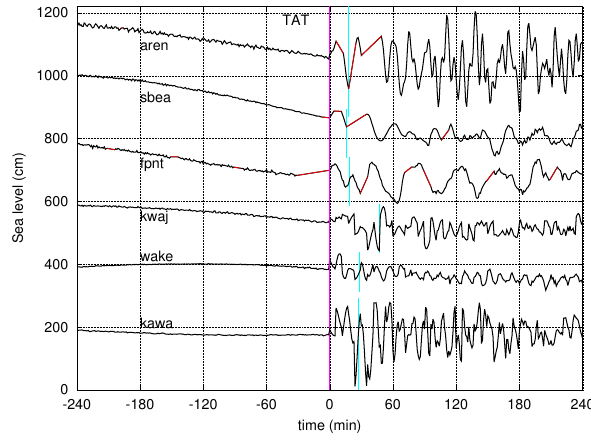
Fig. 3c. Examples of analyzed records given to show how the first tsunami wave has been characterized in case of missing data and in case of complex signals. Records are not detided and are aligned starting from TAT. The end of the first wave is indicated with a light blue line. The records of Arena Cove, California (aren), of South Beach (sbea) and Fort Point (fpnt) both in San Francisco, California, have substantial data gaps making it hard to identify TAT as well as duration and magnitude of the first wave. The records of the Kwajalein atoll, Marshall islands (kwaj), of the Wake island, USA (wake) and of Kawaihae, Hawaii (kawa) are quite complex and the first tsunami wave is modified by short-period